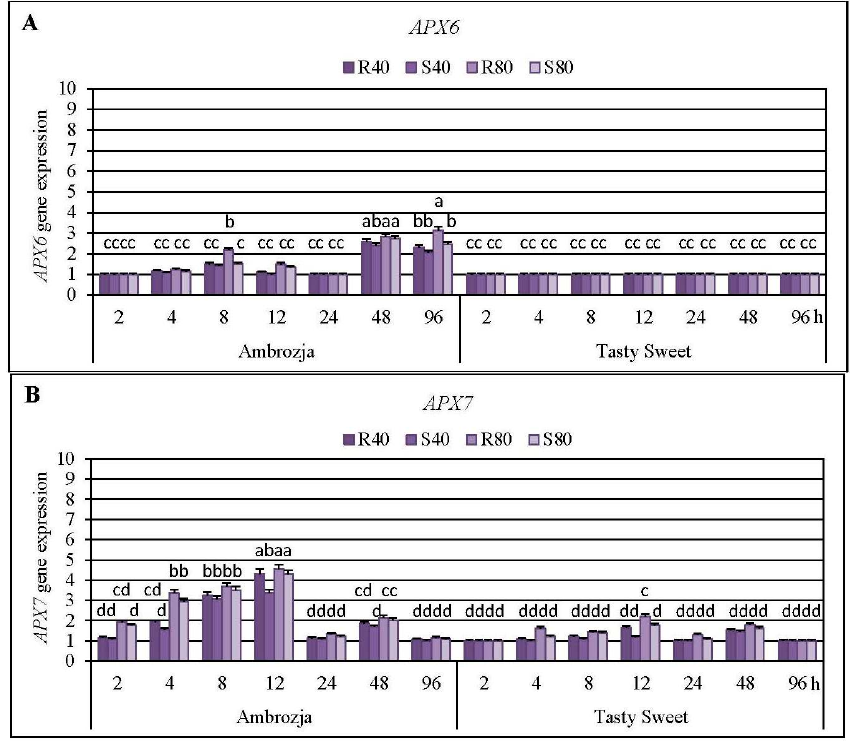
Figure 5. Impact of the cereal aphid’s attack on relative expression of APX6 ( A ) and APX7 ( B ) genes in the seedlings of Ambrozja and Tasty Sweet maize varieties (first phase of the experiments). R40, R80—maize plants of a certain genotype infested with 40 or 80 R. padi females per seedling, accordingly; S40, S80—maize plants of a certain genotype infested with 40 or 80 S. avenae females per seedling, respectively. All data are presented as the mean (±SD) of three independent biotests, and significant differences in abundance of the APX transcripts are denoted by different letters ( p < 0.05; post-hoc Tukey’s test).